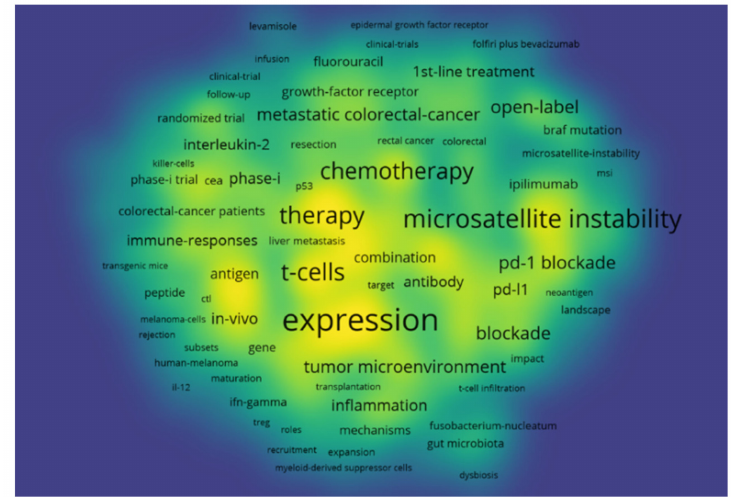
Figure 4. Bibliometric analysis of the keywords in the publications of immunotherapy in CRC showing the co-occurrence of keywords, where the size of nodes indicates the frequency of occurrence.